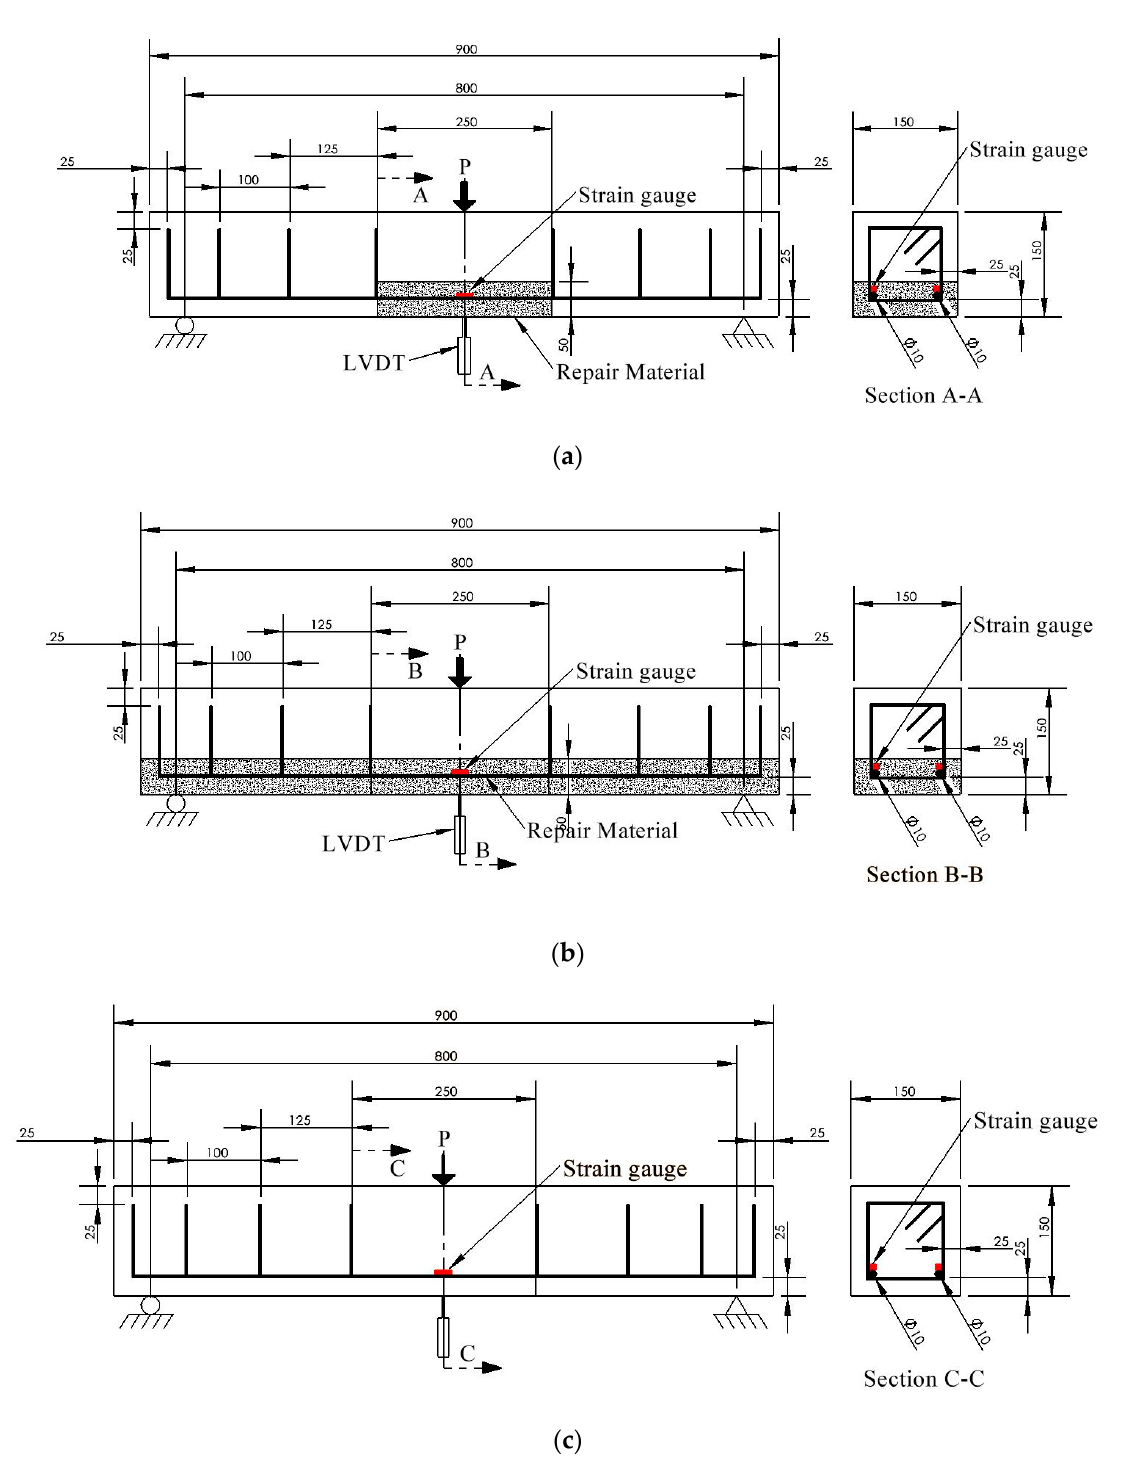
Figure 1. Steel reinforcement details for ( a ) RC beam with 1/3-span repair ( b ) RC beam with full- length repair ( c ) Intact beam without repair (all dimensions in mm).